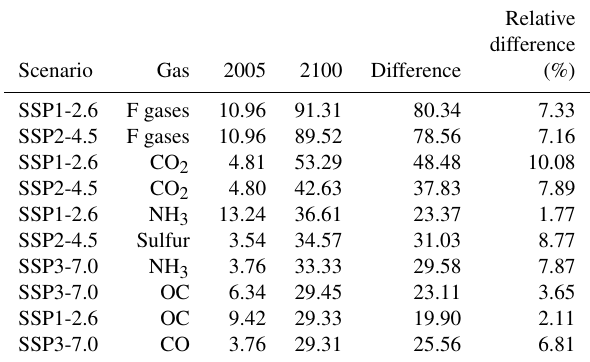
Table H1. The dispersion ( c v ) for the first modeled period and last modeled period for scenarios with maximum model representation. Here we show the 10 highest EOC dispersion values for a given scenario–species